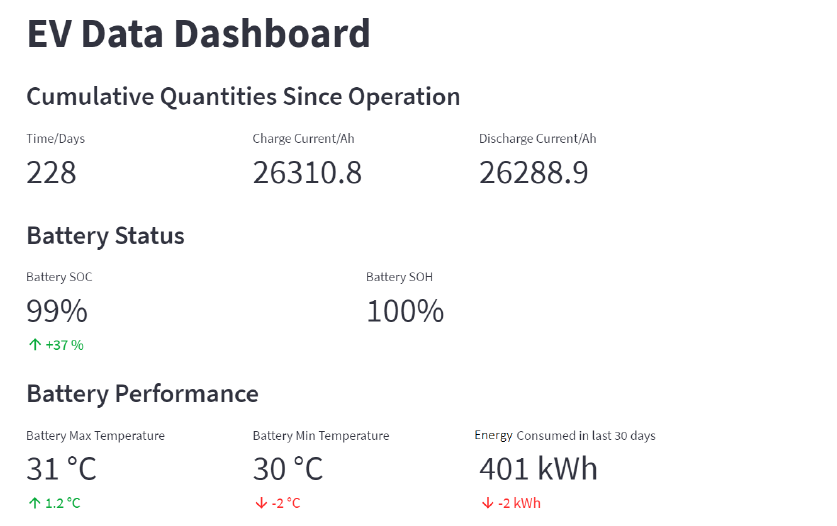
Figure 9. BEV data dashboard showing high-level instantaneous details on the